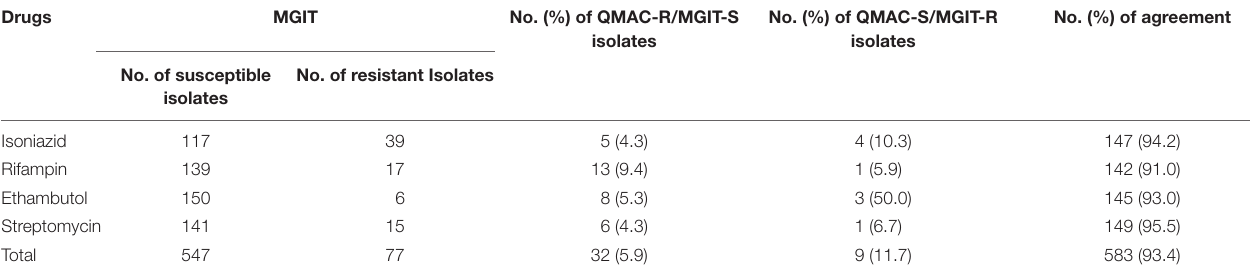
TABLE 4 | Agreement of drug susceptibility testing using QMAC-DST compared to drug susceptibility testing using BACTEC MGIT 960.